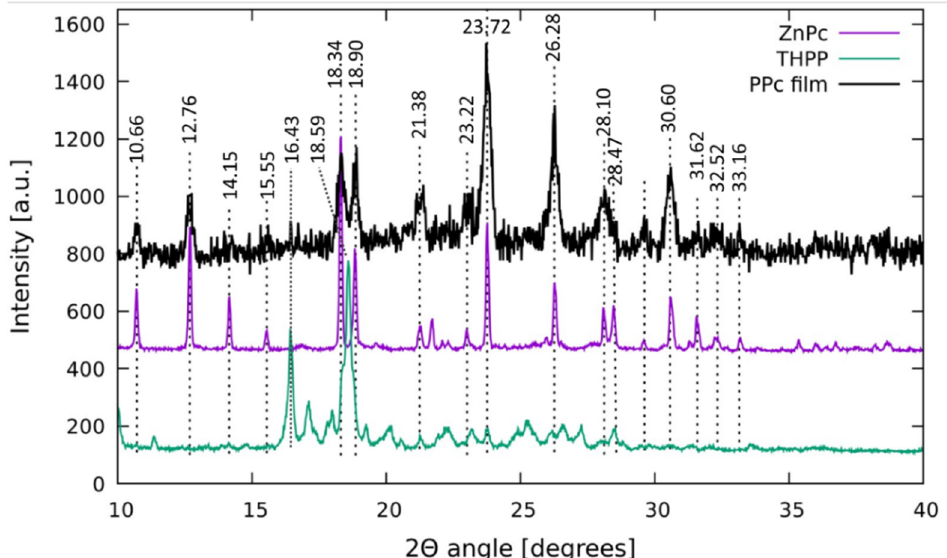
Figure 4. XRD patterns of the blend deposited on the glass substrate (PPc film), THPP powder, and ZnPc